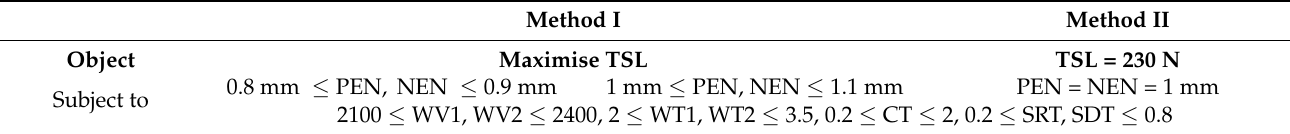
Table 6. Two optimisation methods.